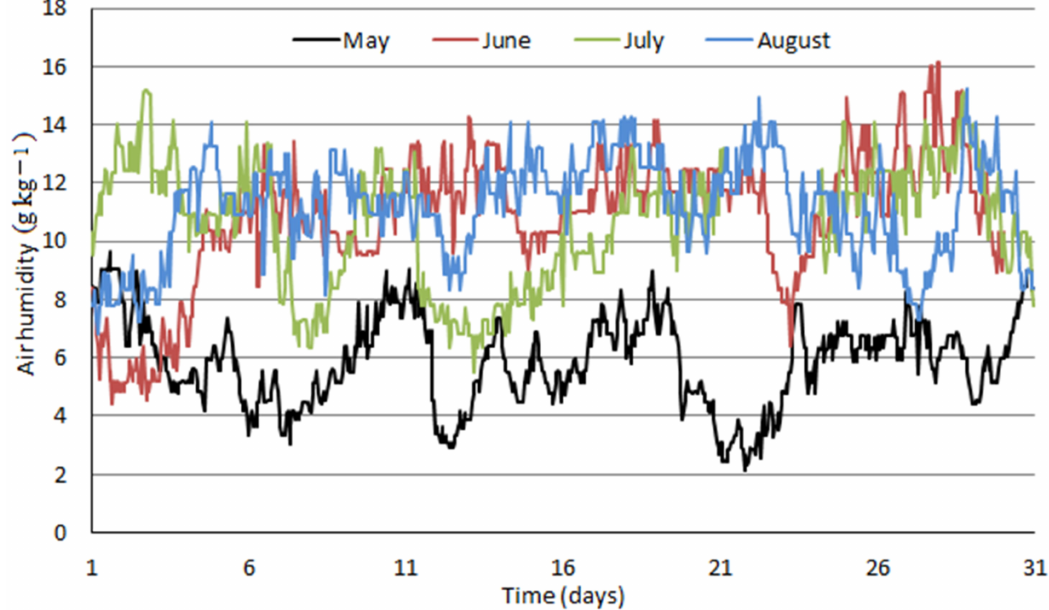
Figure 5. Hourly averages of air humidity in Košice—Center from May 2020 to August